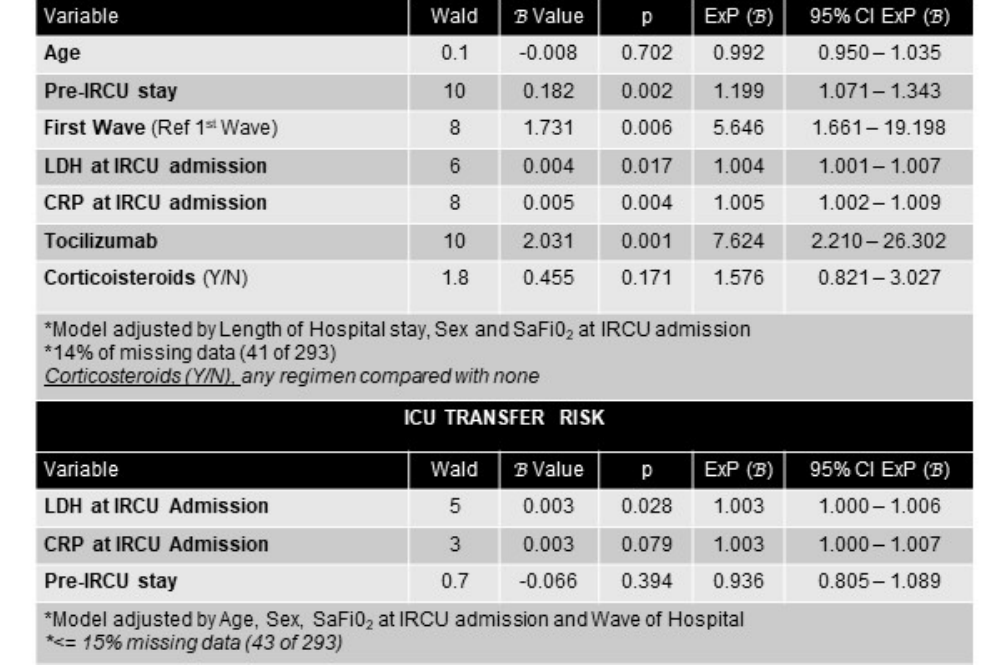
Figure 5. Multivariate logistic regression analysis. Factors associated with survival, ICU transfer, and intubation in the non-NIV group.